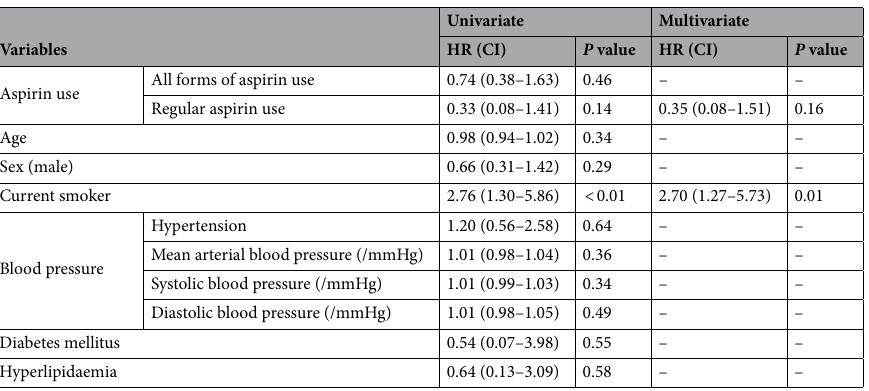
Table 2. Univariate and multivariate regression analysis stratified by cohort. HR Hazard ratio; CI confidence